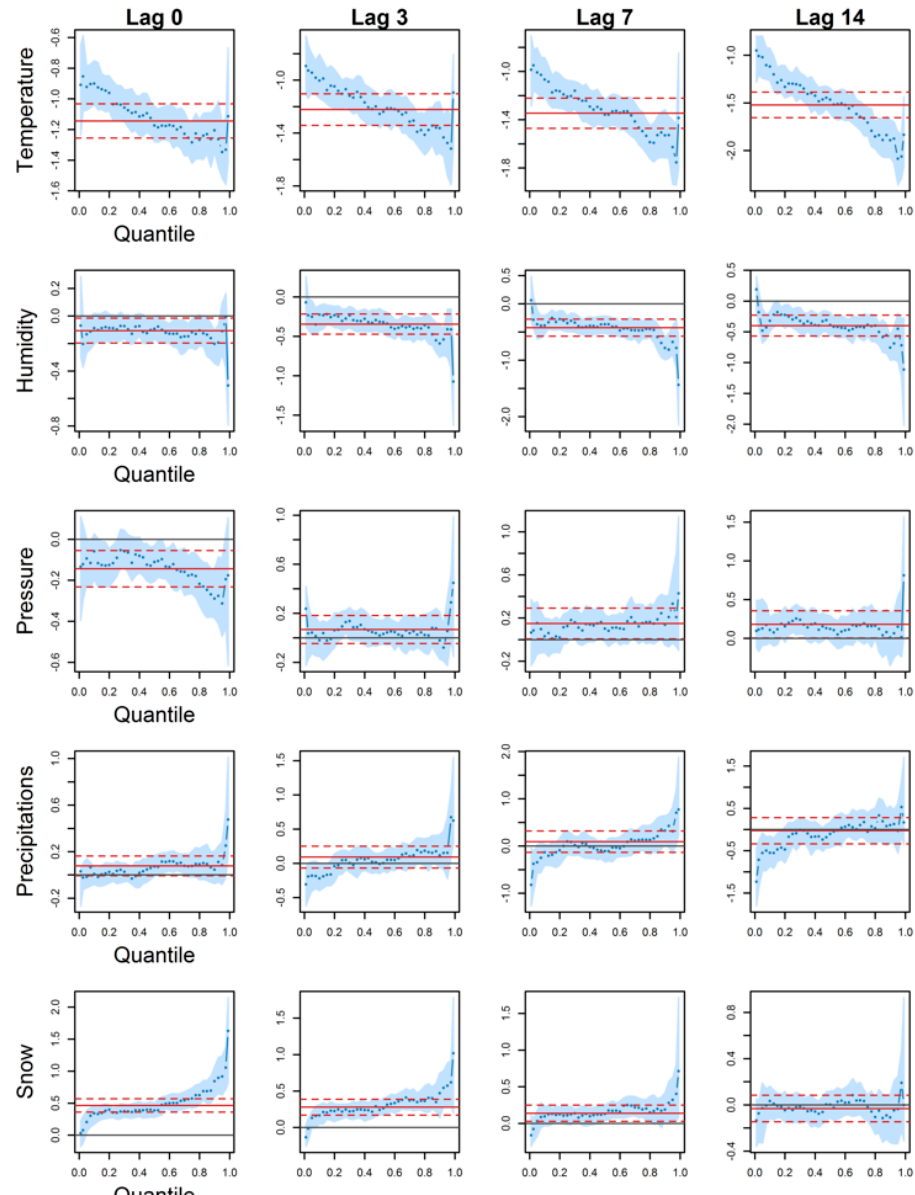
Figure 3. QR (blue dots) and classical mean regression (red full line) coefficients against quantiles for deaths in Montreal. 95% confidence intervals are shown in light blue for QR and in red dashed lines for classical mean regression.